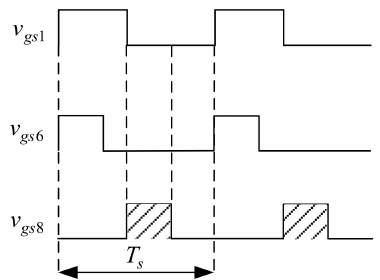
Figure 6. Two-phase switching period equal to that of the main